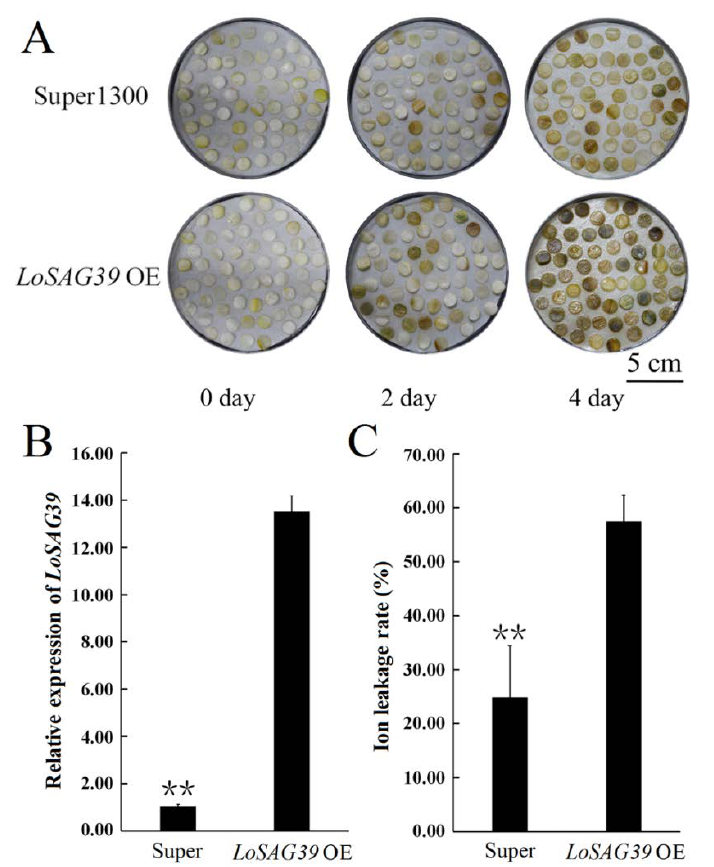
Figure 5. Overexpression of Lilium oriental SAG39 ( LoSAG39 ) in tepal discs of lily ( L. oriental ‘Siberia’). ( A )Phenotype of LoSAG39 OE and super vector control samples. ( B , C ) Expression of LoSAG39 and ion leakage rate in LoSAG39 OE and super vector control samples. The data represent the mean ± SE of three biological replicates. ** p < 0.01 (Student’s t-test).